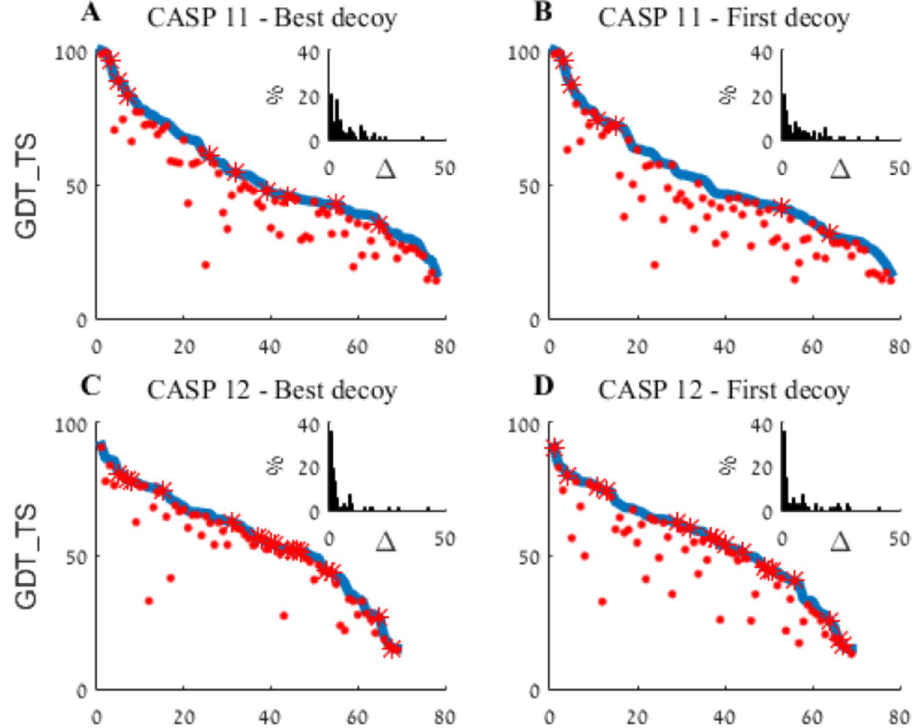
Figure 3. Aggregated best models WeFold vs. all CASP groups. In each panel, targets are sorted in descending order of the best decoy submitted (blue line). The best WeFold decoy for each target is marked by a red dot or, when coincides with the overall best, red asterisk. The insert histograms depict the distributions of quality differences ( Δ ) between the best decoys and their corresponding best WeFold decoy. ( A and B ) – CASP11; ( C and D ) – CASP12; ( A and C ) – Best out of five; ( B and D ) – First